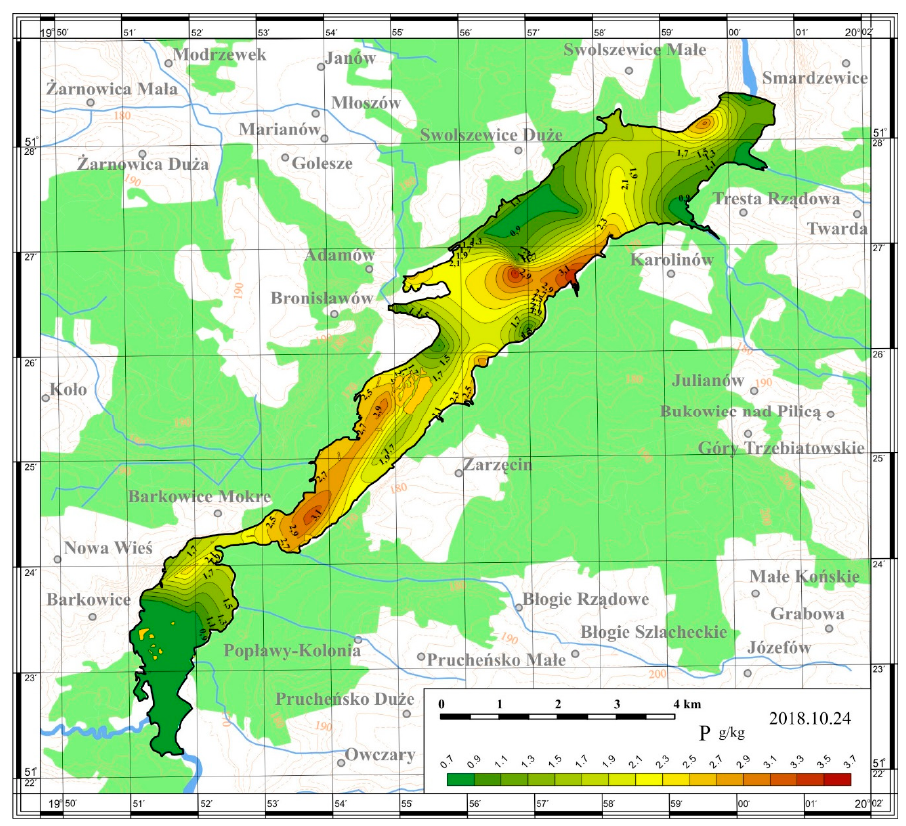
Figure 5. Spatial distribution of the total phosphorus content in the bottom sediments of the Sulejów Figure5. SpatialdistributionofthetotalphosphoruscontentinthebottomsedimentsoftheSulej ó Reservoir.